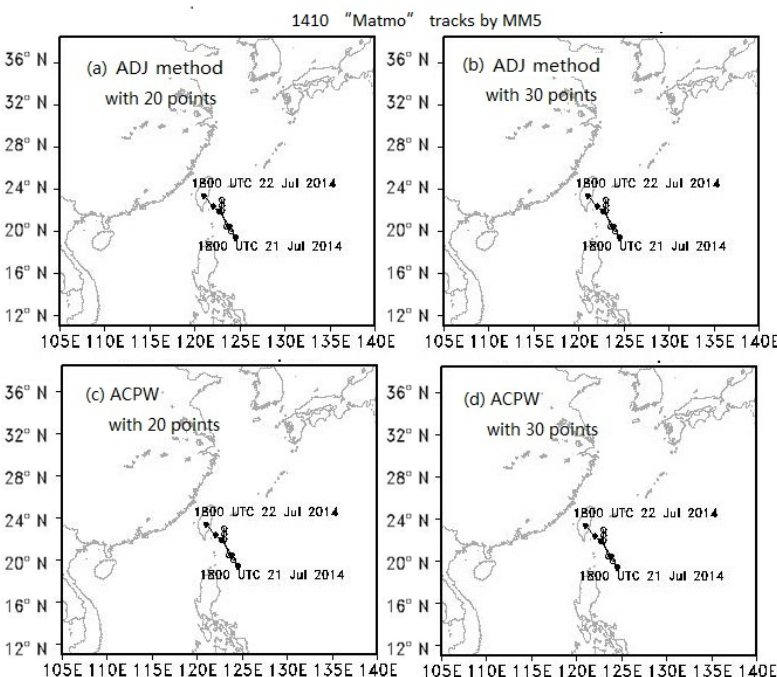
Figure 18. Simulated TC tracks from MM5 through the insertion of the amended CNOPs, which are reduced by a factor of 0.5 only in the sensitive regions, into the initial state for TC Matmo.